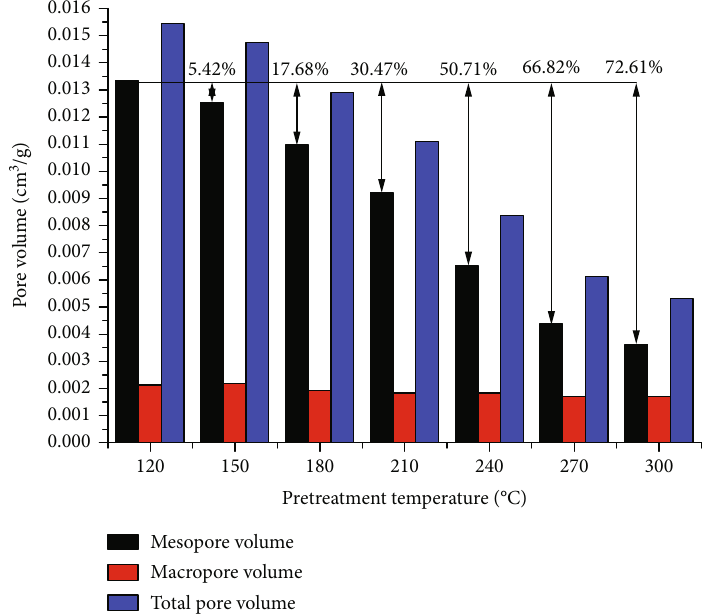
Figure 5: The dynamic change of meso- and macropore volumes under various pretreatment temperatures.